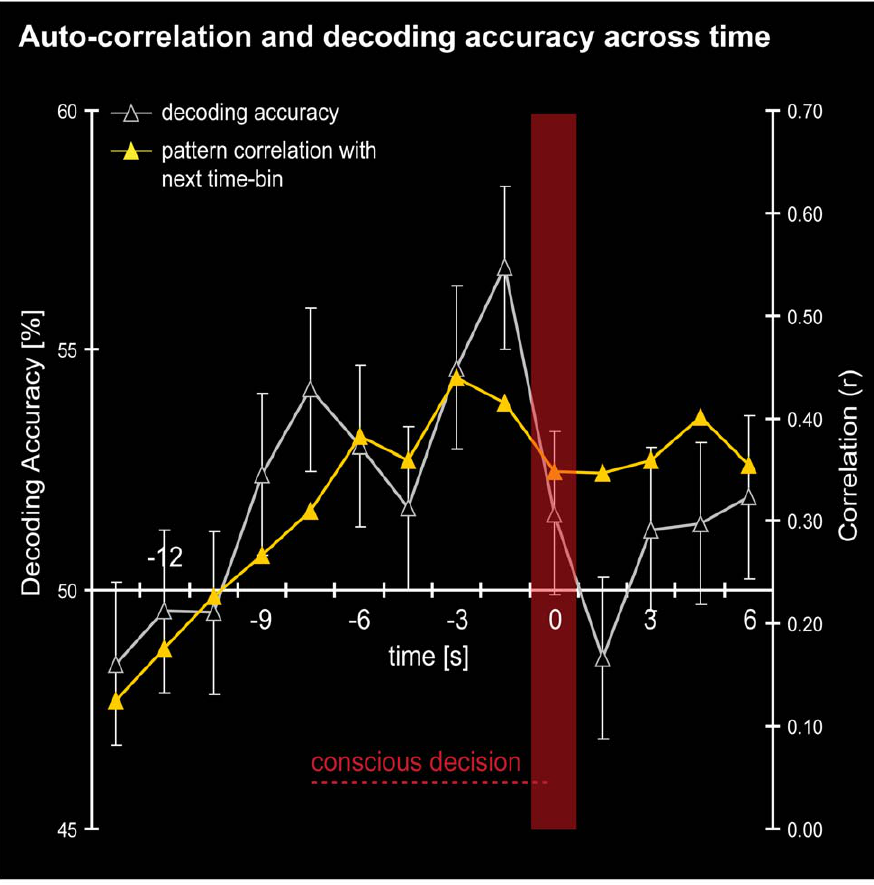
Figure 7. Correlation analysis for spatial activation patterns. Displayed is the decoding accuracy across time from the best cluster (empty gray triangles) as well as the correlation of each time-bin with its preceding time-bin (filled yellow triangles) as a measure of pattern similarity (averaged across patterns for left and right decisions). Up to the time of the decision (time 0 s) the decoding accuracy and pattern similarity increased in a similar fashion. After the decision, the pattern similarity dropped slightly and patterns did not predict the decision outcome anymore.